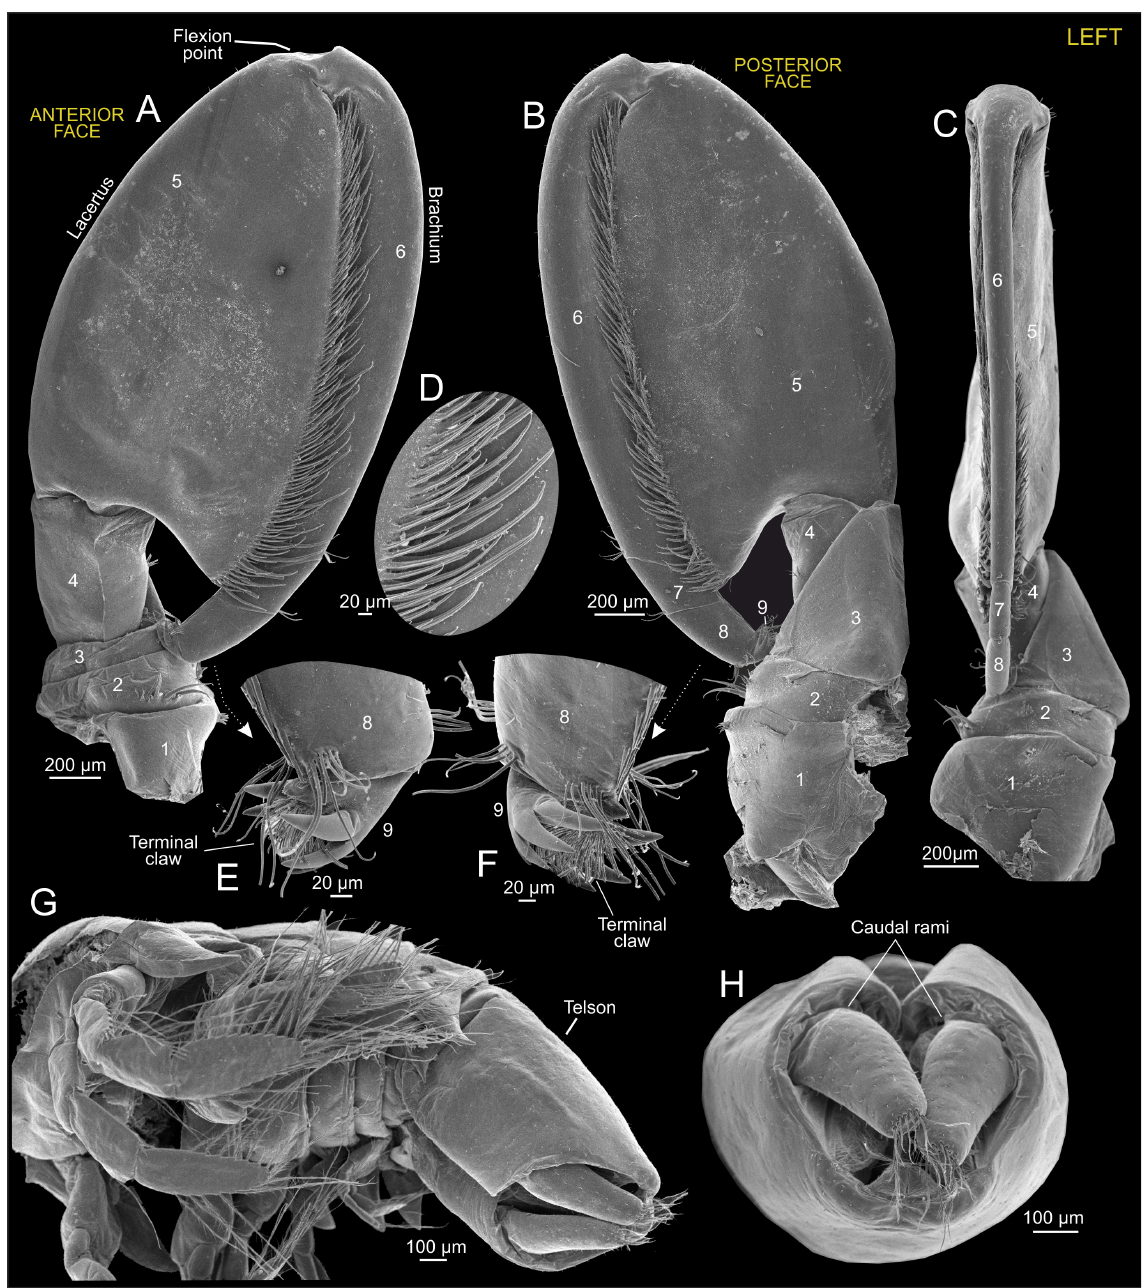
Fig. 8. Godzillius louriei sp. nov., holotype (NHMD 669698), left maxilliped (mxp) scanning electron microscopy. A . Anterior face of mxp. B . Posterior face of mxp. C . Apical view of mxp. D . Vertical striations of setae along the surface of the lacertus. E . Terminal claw, anterior face. F . Terminal claw, posterior face. G . Posterior segments and telson, ventral view. H . Telson, lateral view; caudal rami separated by invagination of the telson. Small numbers represent segments of